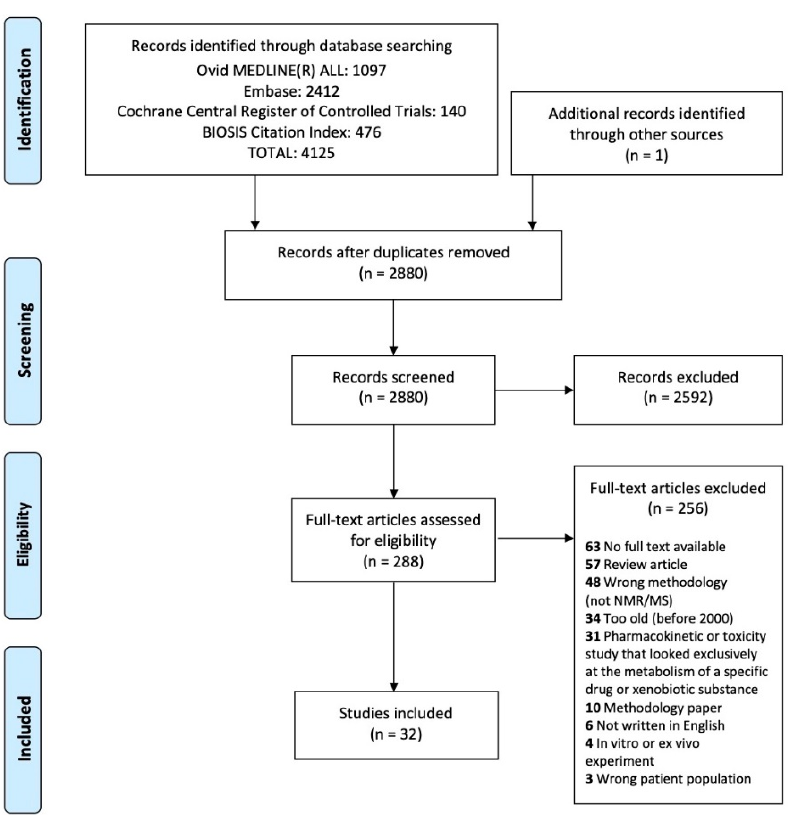
Figure 2. Article screening process.